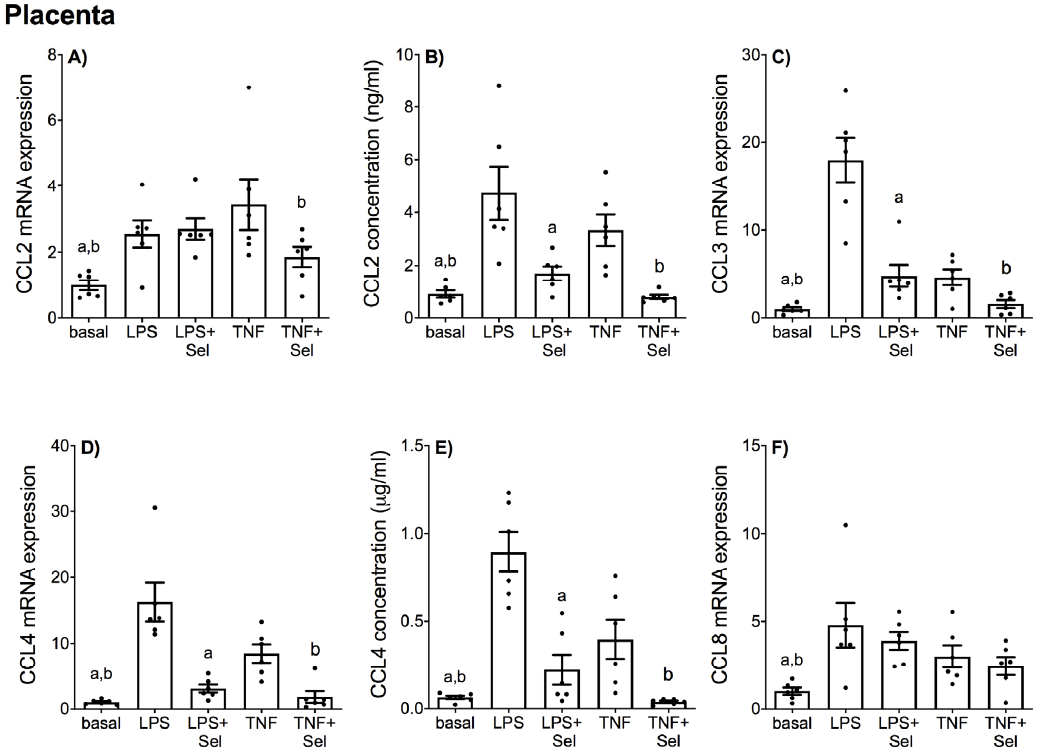
Figure 4. Effect of selenium on CCL chemokine expression in human placenta. Placenta was incu- bated with or without 10 µM sodium selenite (Sel) for 1 h and then stimulated with 10 µg/mL LPS or 10 ng/mL TNF- α for a further 20 h ( n = 6 patients). ( A , C , D , F ) CCL2, CCL3, CCL4 and CCL8 mRNA expression was analysed by RT-qPCR and fold change was calculated relative to basal ex- pression. ( B , E ) The concentration of CCL2 and CCL4 in the conditioned media was assayed by ELISA. For all graphs, individual data points represent six independent experiments and are dis- played as mean ± SEM. a p ≤ 0.05 vs. LPS, b p ≤ 0.05 vs. TNF; repeated measures one-way ANOVA.